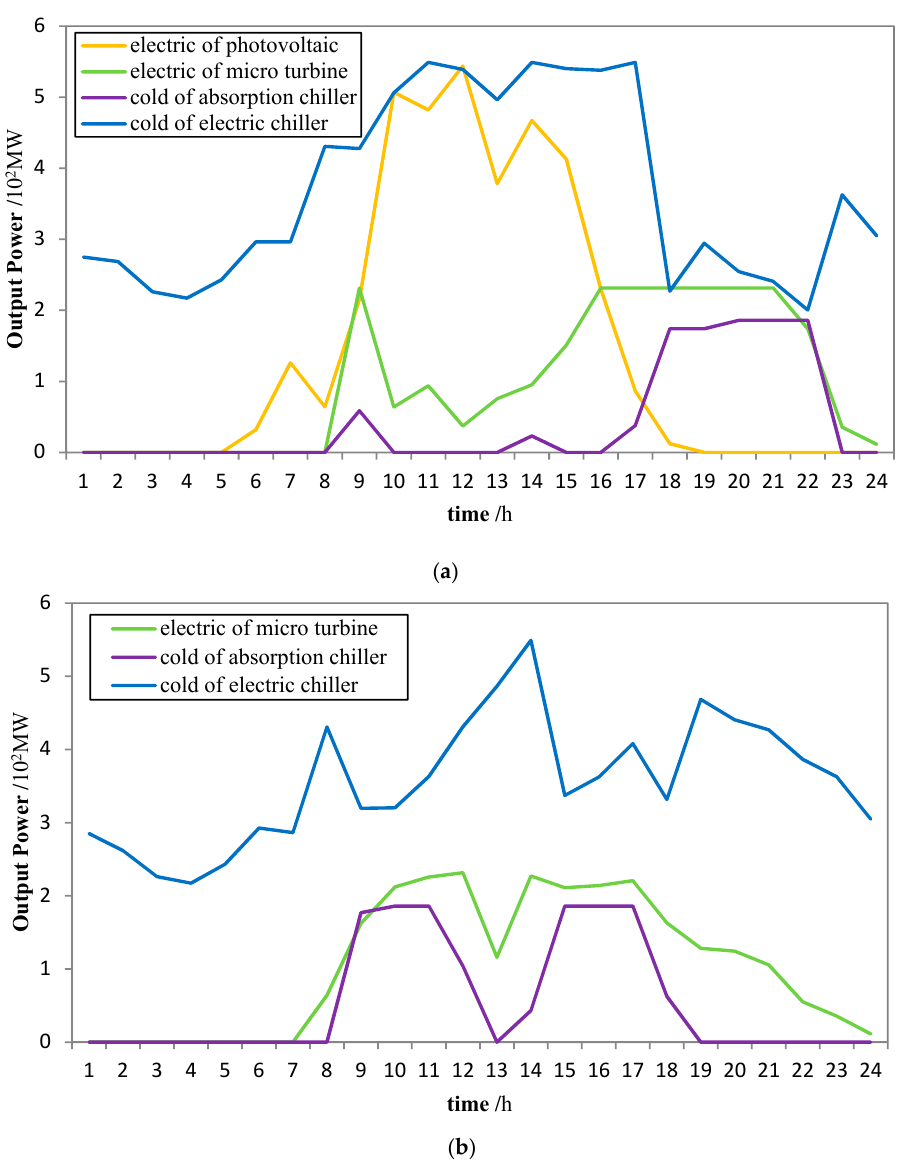
Figure 7. Summer typical day partial devices output power in stage 3 under scenario 5: ( a ) Typical device output power; ( b ) Typical device output power when the PV output is 0. Table 7. Optimal alternative schemes’ typical device planning in stage 3 under scenarios 1, 5, and 9.